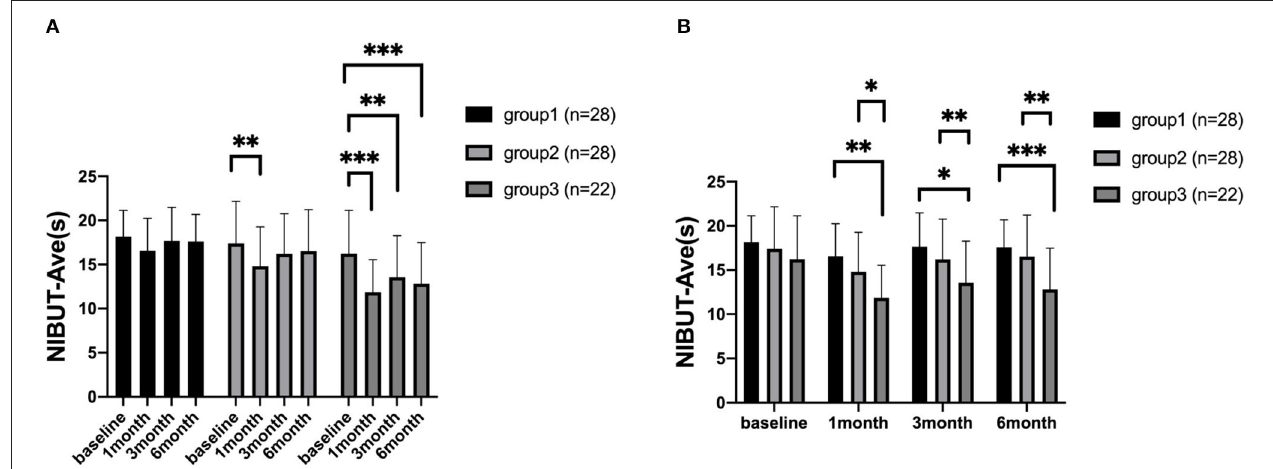
FIGURE 2 | The average non-invasive tear breakup time (NIBUT-Ave) of patients. The comparison of different time points measured preoperatively, at 1, 3, and 6 months after corneal refractive surgery (A) . The comparison among the three groups (B) . * P < 0.05, ** P < 0.01, and *** P < 0.001 (NIBUT-Ave, The average non-invasive tear film break up